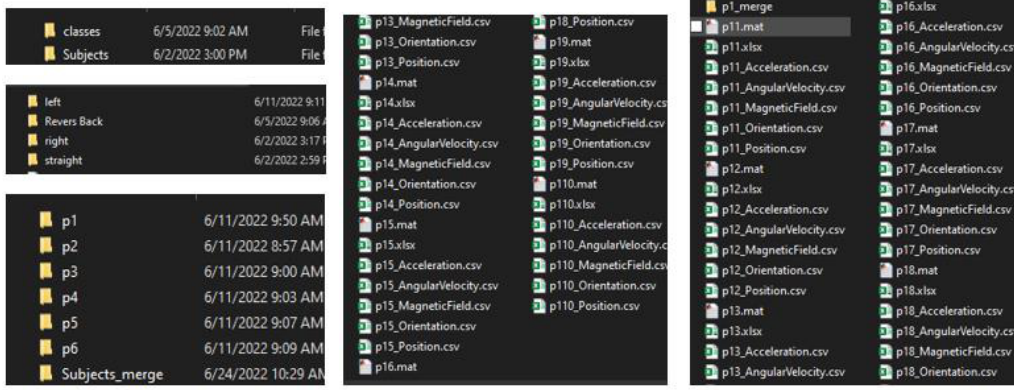
Figure 39. Site two smartphone sensor data.